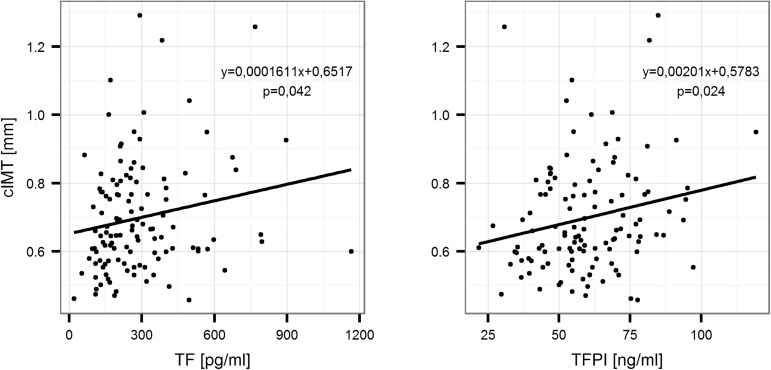
Linear relationship between the concentrations of TF and TFPI and the value of cIMT for the entire study group.Univariate linear regression.